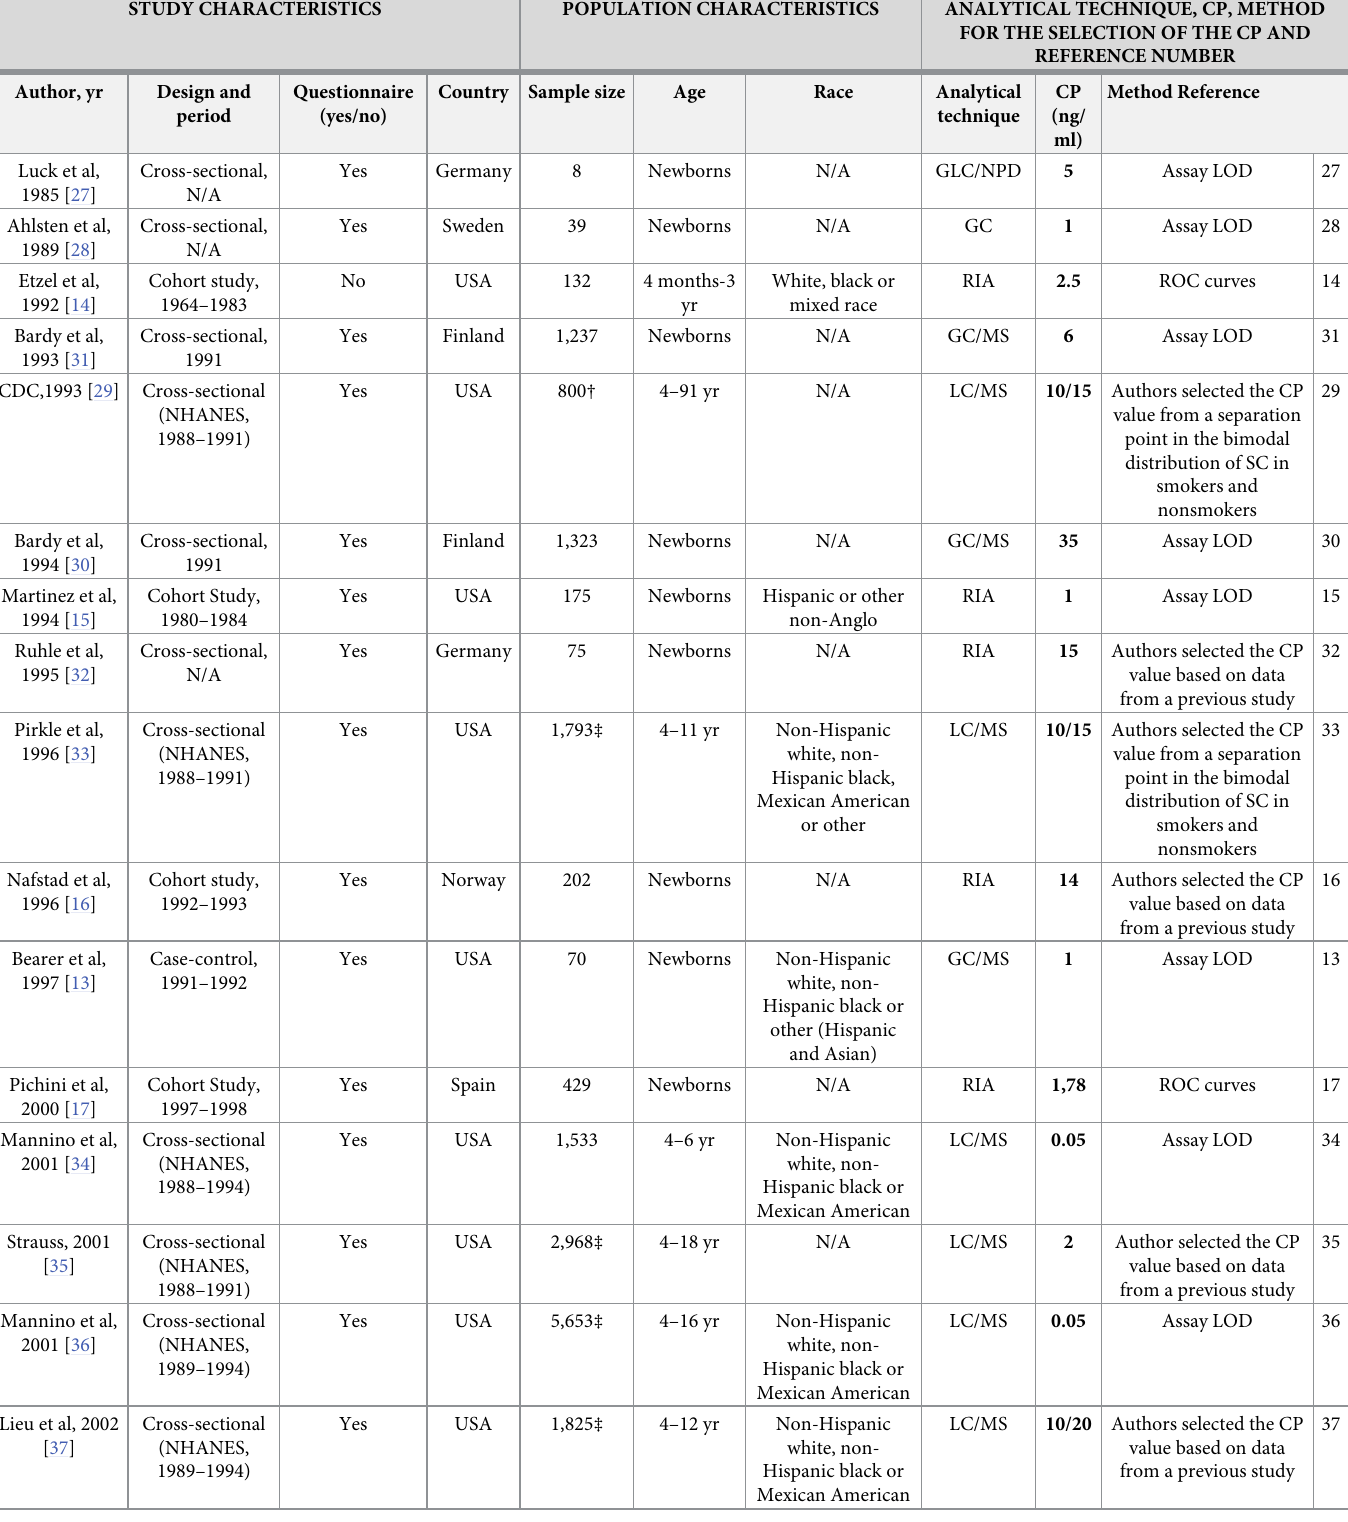
Table 1. Study and population characteristics; analytical technique for serum cotinine quantification; cotinine cut-points (CP) and method for their selection. STUDY